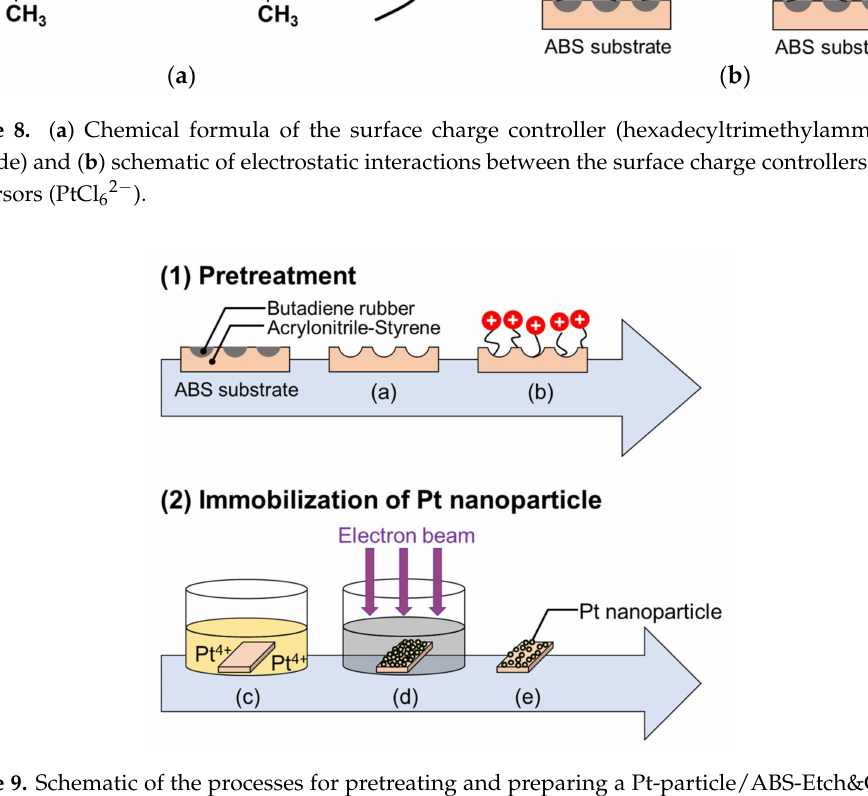
Figure 9. Schematic of the processes for pretreating and preparing a Pt-particle/ABS-Etch&Charge sample using an EBIRM through pretreatment: ( a ) KMnO 4 /H 2 SO 4 etching to dissolve butadiene rubber on the ABS surface; ( b ) surface charge control; ( c ) immersion of the pretreated ABS substrate in the Pt precursor solution; ( d ) irradiation with an electron beam; and ( e ) removing it from the solution, washing using an ultrasonic cleaner, and drying by blowing with N 2